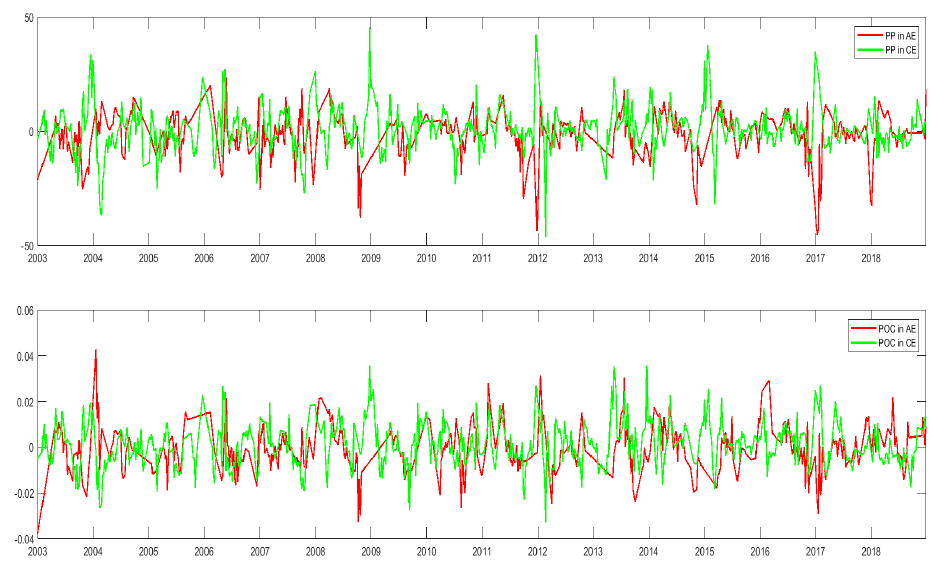
Figure 17. Anomalous time series of PP and POC in the center of anticyclonic eddies (AEs) and cyclonic eddies (CEs) in the NSCS (unit: mg/m 3 ).